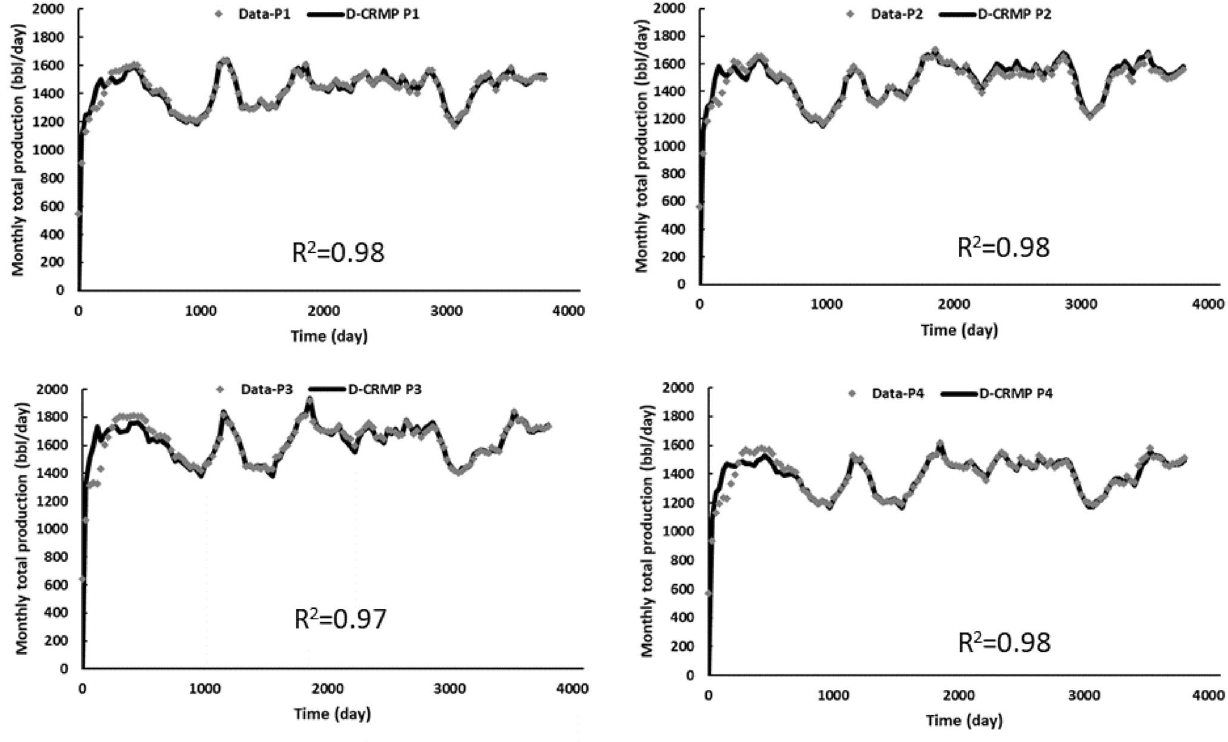
Fig. 22 Total production match by D-CRMP for all producers in case V